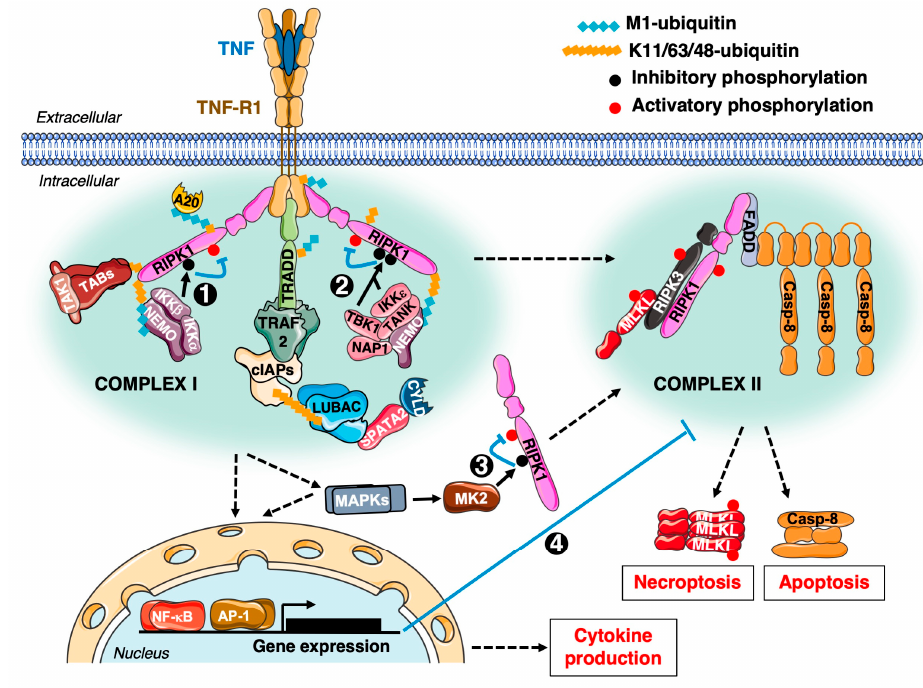
Figure 1. Tumor Necrosis Factor (TNF)/TNF-Receptor 1 (TNFR1)-mediated signalling and cell death